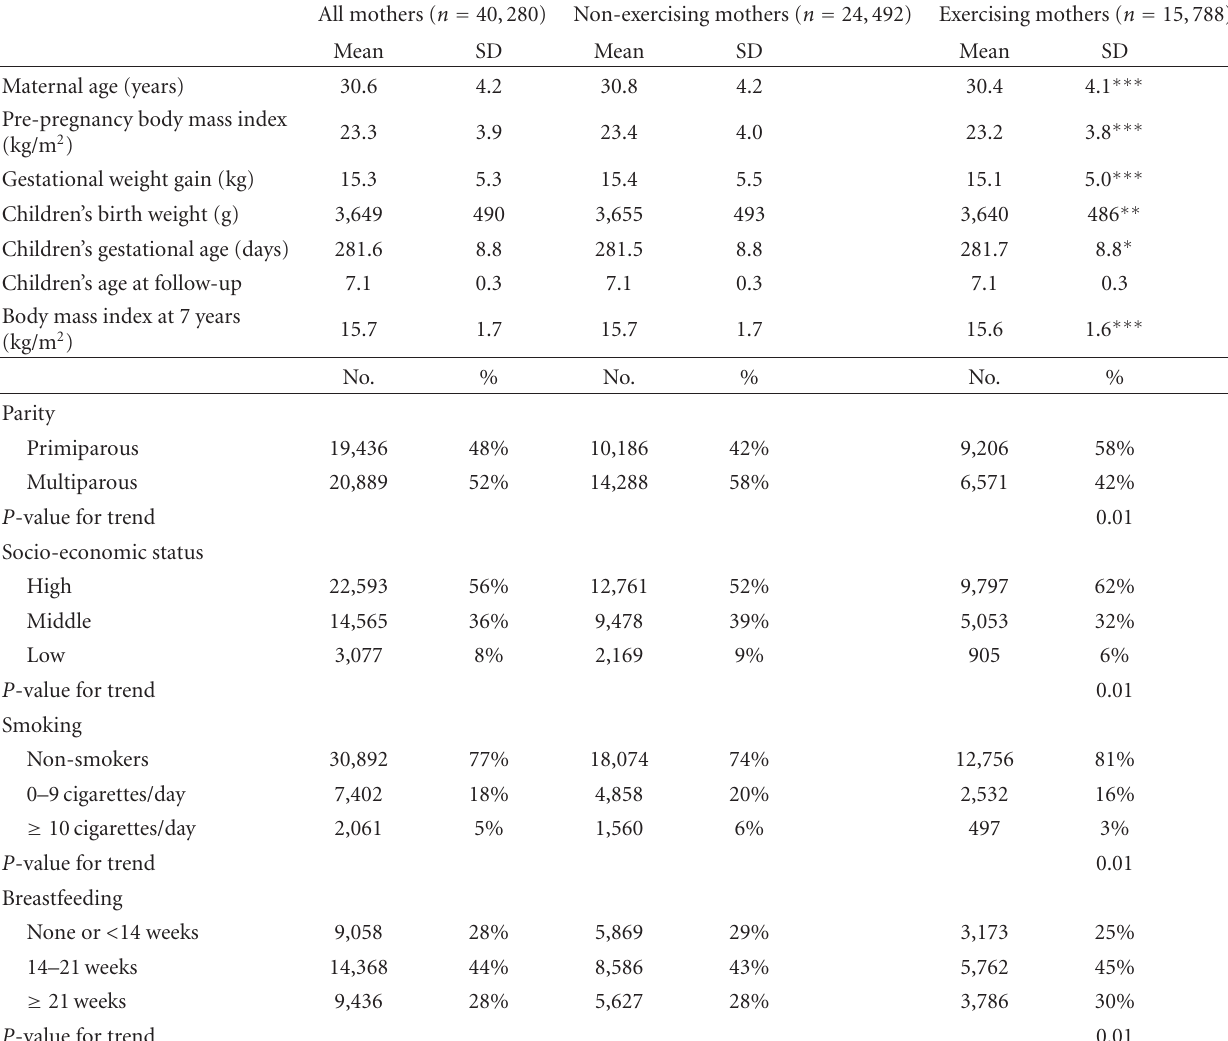
Table 1: Characteristics of mothers according to recreational exercise in early pregnancy a , Danish National Birth Cohort,